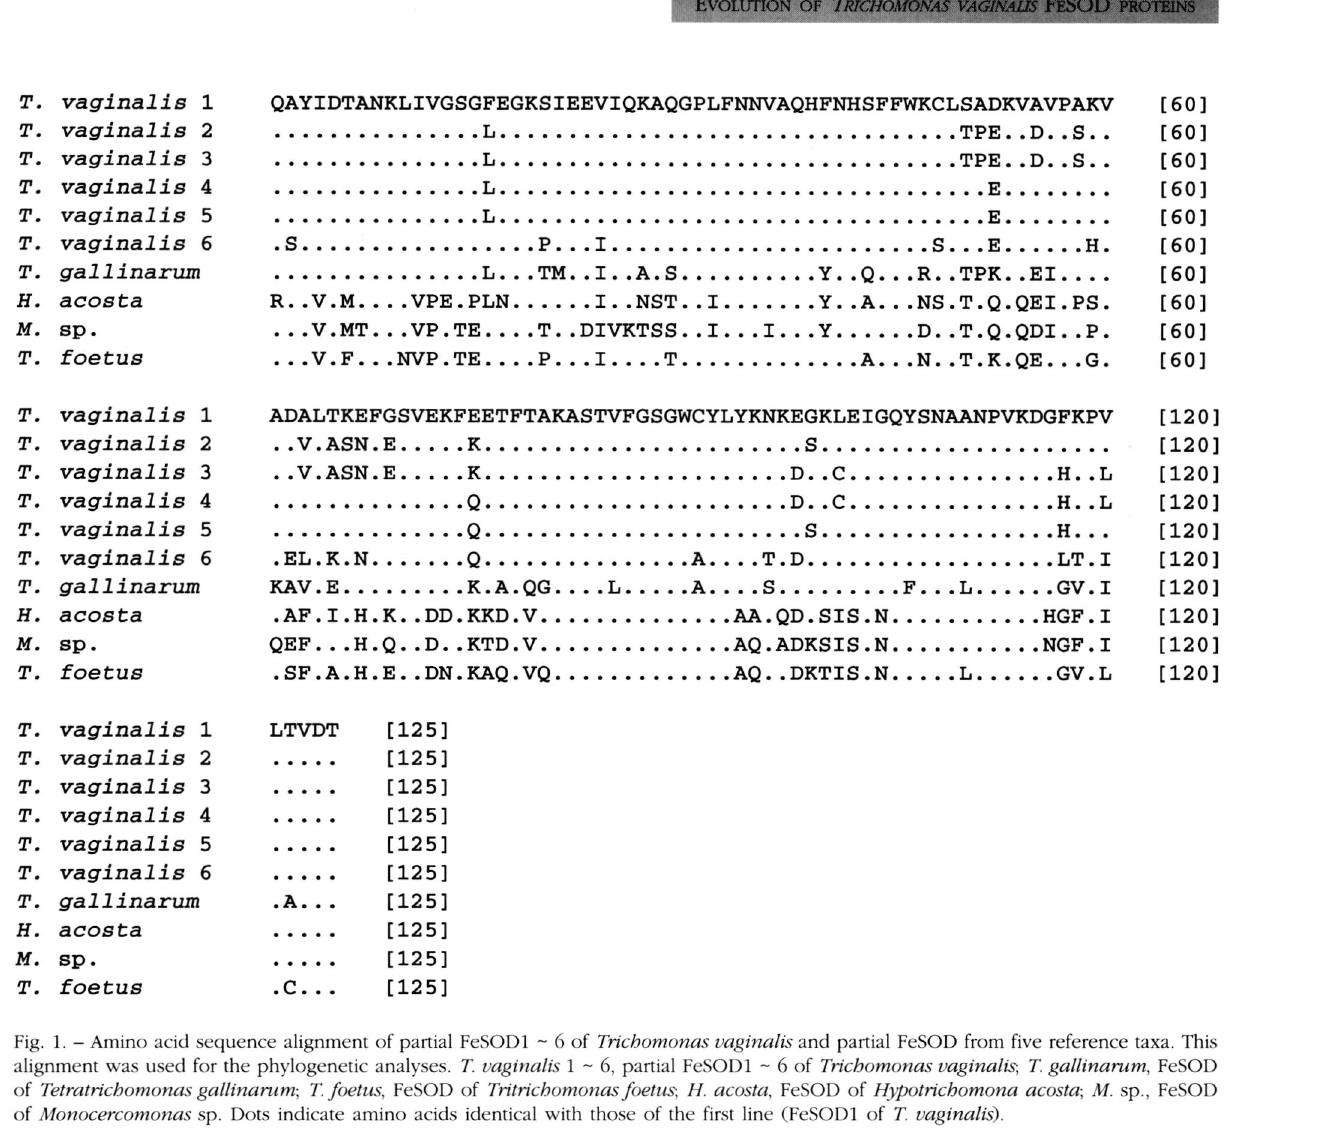
(Fig. 2). As a result, T.